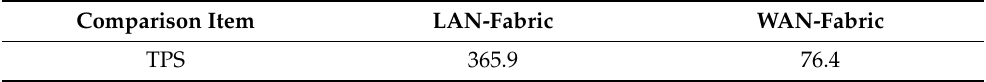
Table 3. Throughput of a distance-based different network. Comparison